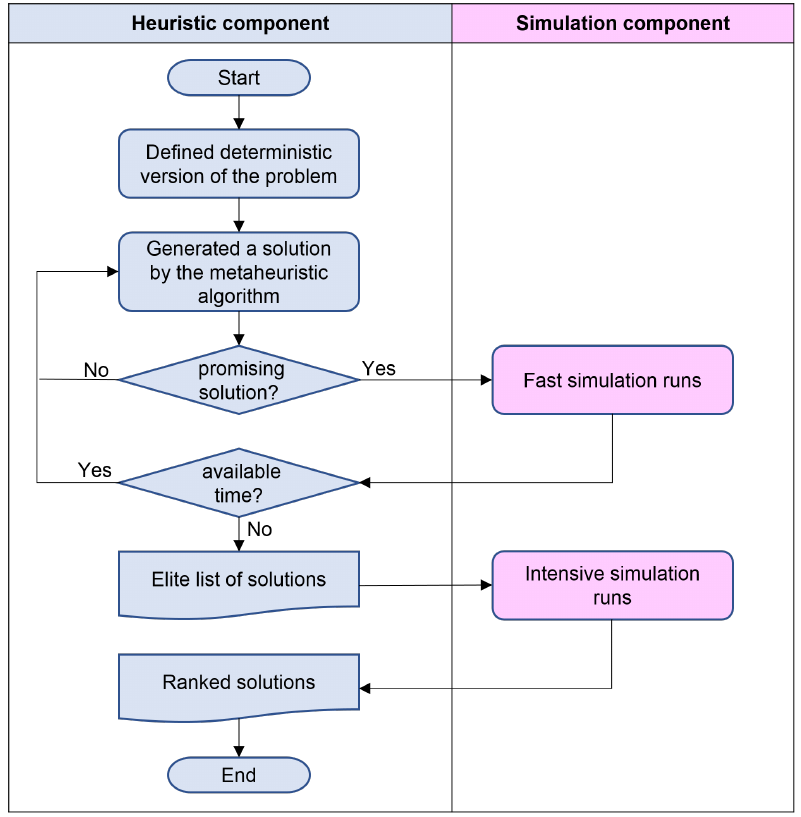
Figure 3. Simheuristic